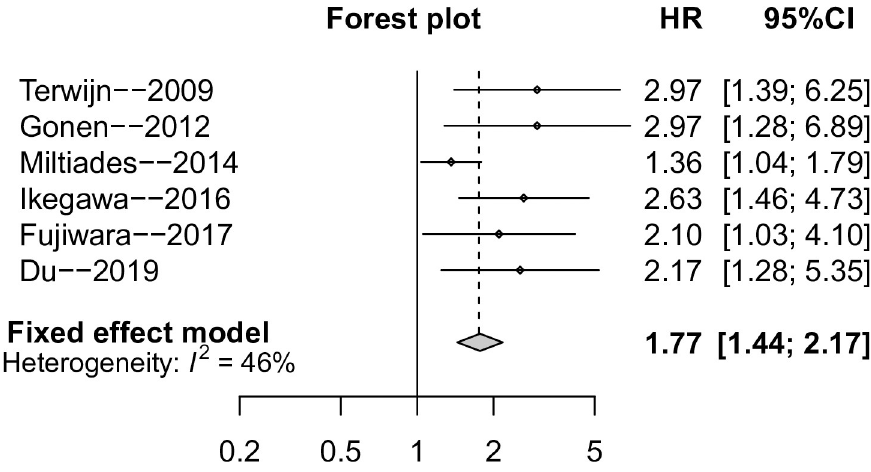
Fig 3. Meta-analysis of the association between CD25 expression and DFS/RFS/EFS in patients with AML.